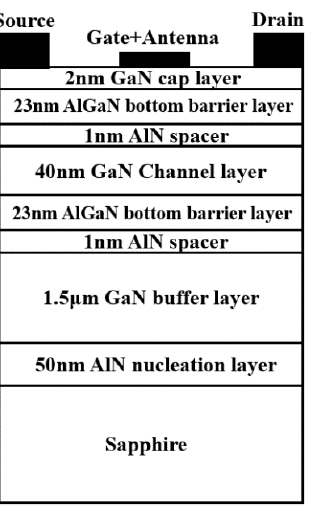
Figure 5. The cross-sectional diagram of the prepared DC GaN HEMT THz detector.